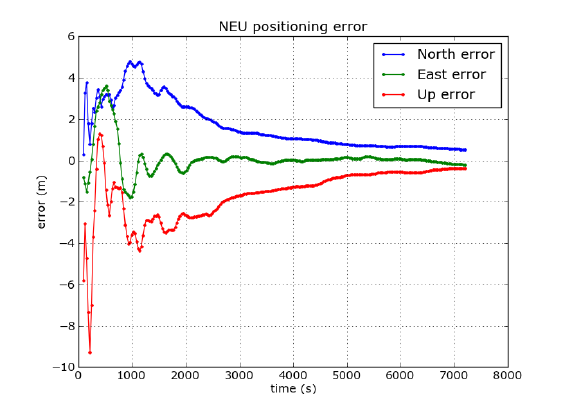
Figure 2: Methodology of combined (GR) PPP processing